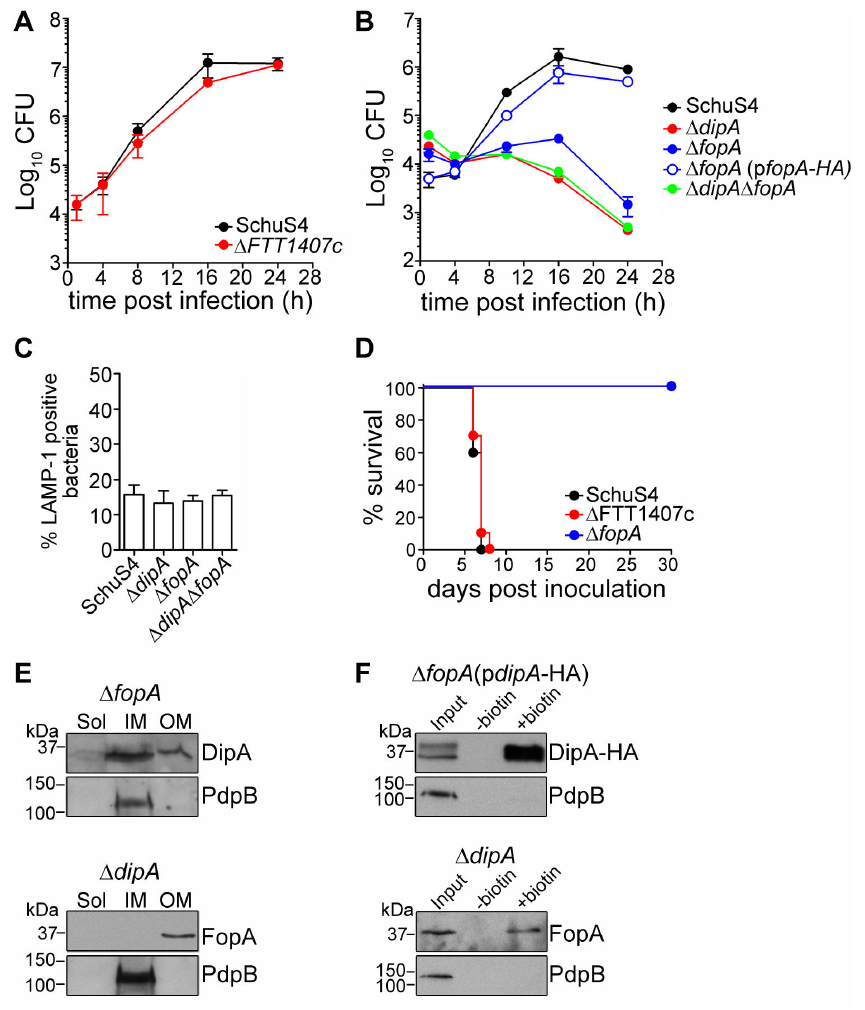
Figure 6. FopA is required for SchuS4 intracellular growth in BMMs and virulence in mice, but not for DipA outer membrane and surface localization. (A) Intracellular growth of SchuS4 and its isogenic ΔFTT1407c mutant in BMMs. BMMs were infected with either strain and CFUs were enumerated at various times p.i. Data are means ± SD from a representative experiment performed in triplicate out of two independent repeats. (B) Intracellular growth of SchuS4, its isogenic Δ fopA and Δ dipAΔfopA mutants and the complemented Δ fopA (p fopA-HA ) strains in BMMs. BMMs were infected with either strain and CFUs were enumerated at various times p.i. Data are means ± SD from a representative experiment performed in triplicate out of two independent repeats. (C) Quantification of bacteria enclosed within LAMP-1-positive phagosomal membranes. BMMs were infected for 1 h with either SchuS4 or its isogenic Δ dipA , Δ fopA and Δ dipAΔfopA mutants. Samples were processed for immunofluorescence labelling of bacteria and LAMP-1-positive membranes. Infected BMMs were scored for number of infected cells with bacteria enclosed within LAMP-1-positive compartments. At least 100 bacteria per experiment were scored for each condition. Data are means ± SD from three independent experiments. (D) Survival curves of BALB/cJ mice infected with SchuS4, SchuS4ΔFTT1407c or SchuS4Δ fopA by intranasal inoculation. Intranasal inocula were 27 (SchuS4), 16 (ΔFTT1407c), and 15 (Δ fopA ) CFUs. (E) Subcellular localization of DipA, FopA, and PdpB from SchuS4Δ fopA (top panels) or SchuS4Δ dipA (bottom panels). Soluble (Sol), inner membrane (IM), and outer membrane (OM) enriched fractions were separated based on Sarkosyl solubility and subjected to immunoblot analysis with antibodies against DipA, FopA, and PdpB. Each fraction was concentrated to the same volume and equal volumes were loaded. (F) Immunoblot analysis of purified surface biotinylated proteins from SchuS4Δ fopA (p dipA-HA ) (top panels) or SchuS4Δ dipA (bottom panels) lysates. DipA-HA was detected using anti-HA antibodies; FopA was detected using anti-FopA antibodies. PdpB and was used as a negative control. Input, untreated (-biotin) and biotinylated (+biotin) samples were processed for CFU enumeration and immunoblotting as described in Materials and Methods. Samples were loaded based on CFU equivalents as follows: 2x10 6 (Input) or 1x10 8 (-/+ biotin) for anti-DipA-HA analysis, 5x10 6 (Input) or 1x10 8 (-/+ biotin) for anti-FopA analysis, 1x10 7 (Input) or 5x10 8 (-/+ biotin) for anti-PdpB